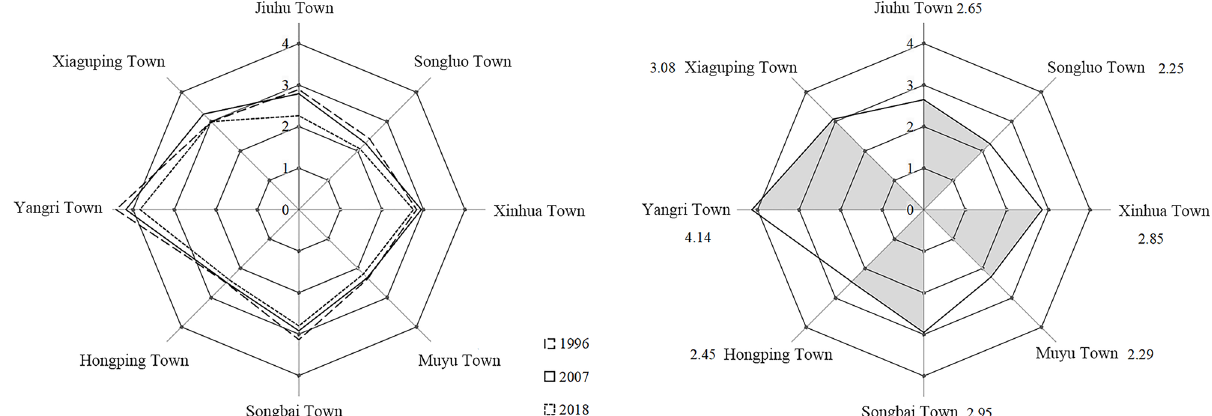
Figure 7. Radar chart of the comprehensive ecological vulnerability index of towns.